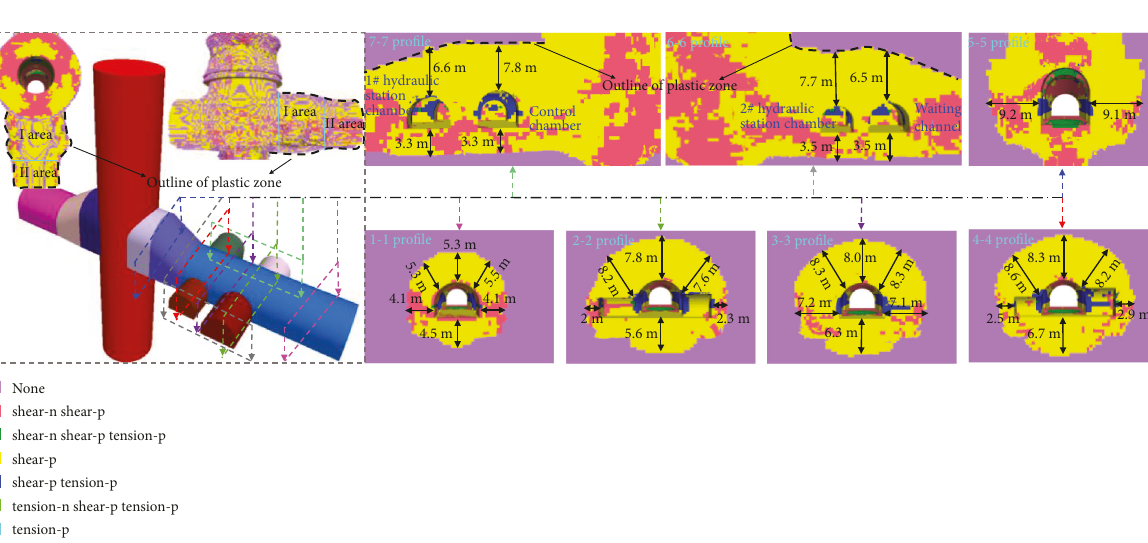
Figure 6: Plastic failure response characteristics of surrounding rock after excavation of each chamber.